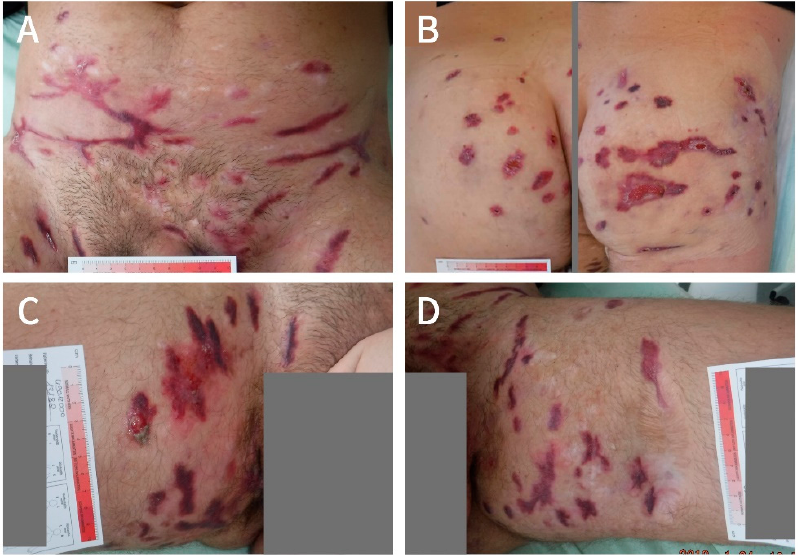
Figure 2. Manifestations of HS the mons pubis area and lower abdomen ( A ), buttocks ( B ), right thigh ( C ) and left thigh ( D ) after deroofing (January 2018).